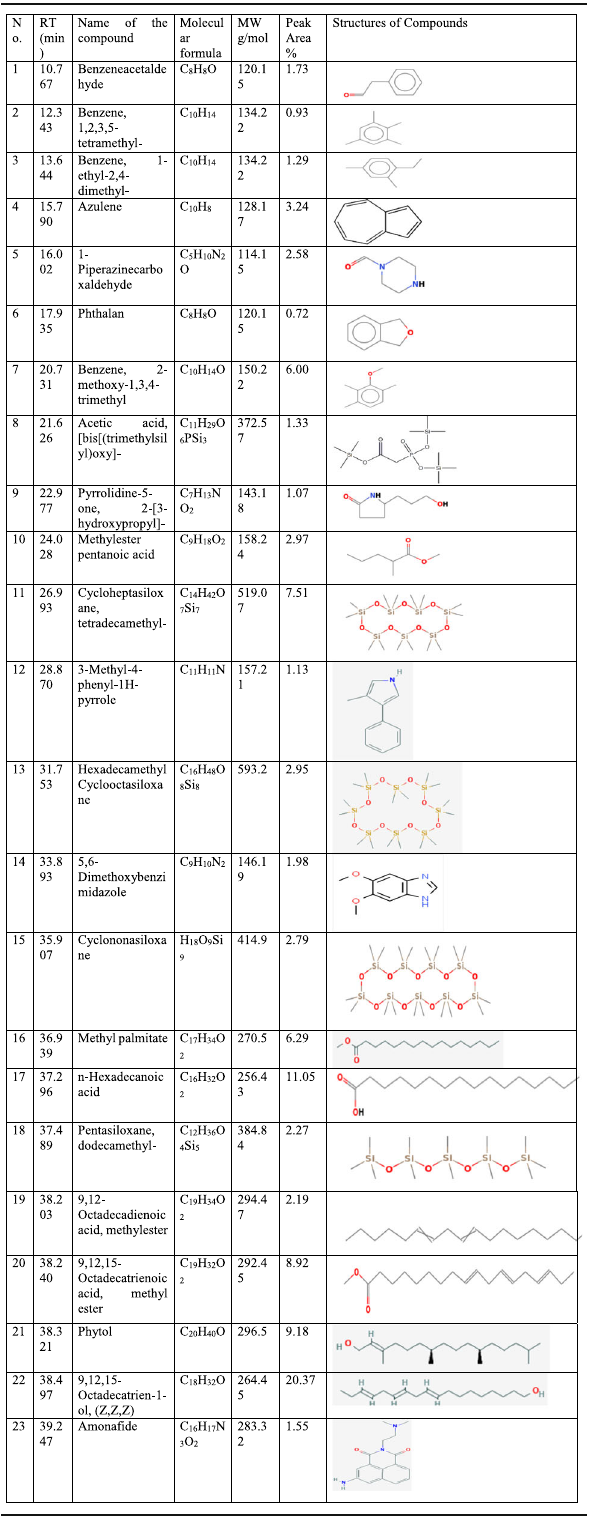
Table 2 Bioactive compounds found in aqueous methanol fraction of H.